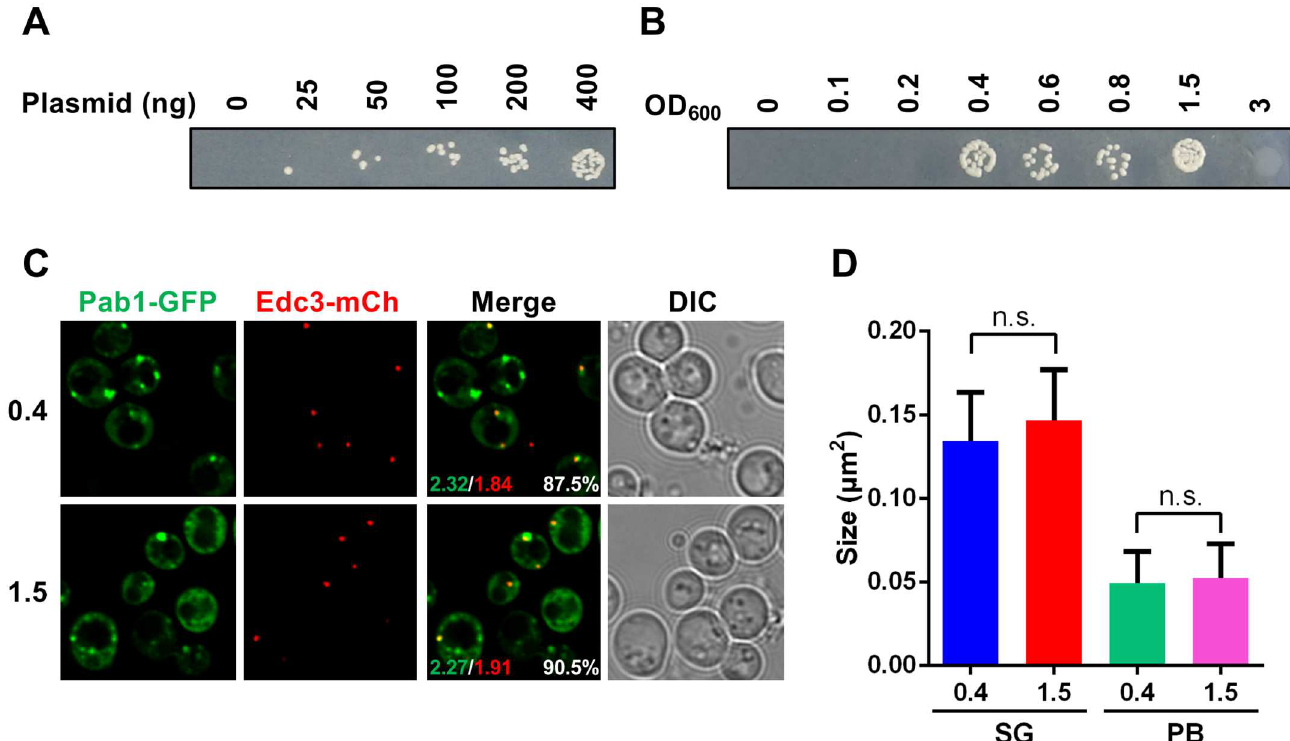
Fig 1. Plasmid and cell concentration affect transformation efficiency. (A) BY4741cells at OD 600 0.5 were transformed with the indicatedamount of pRB1 plasmidusing our automatedmethodology with 4-hour heat shock. After transformation, cells were spotted on a –Uracilagar plate. (B) Different OD 600 cells were transformed with 100ng pRB1 plasmidand heat shocked at 42˚C for 4 hours. (C) Microscopyof BY4741cells originally transformed either at 0.4 or 1.5 OD 600 , and examinedat an OD of 3.5. Numbers indicate averagestress granule(Pab1-GFP, green text) or P-body (Edc3-mCh, red text) foci per cell, and the percentage of Edc3-mCh foci co-localized with Pab1-GFP (white text) (D). Quantificationof stress granule (SG) and P-Body (PB) size in (C). Data is presentedas mean ± standard deviationof 3 independentexperiments; n.s., not significant.